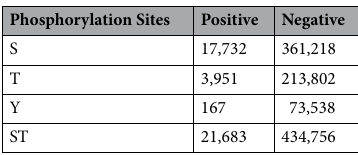
Table 1. Positive and negative windows for phosphorylation in Chlamydomonas reinhardtii